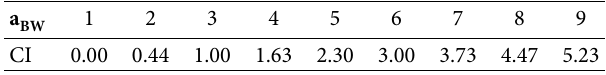
Table 2: Compatibility index specific to the BWM technique.